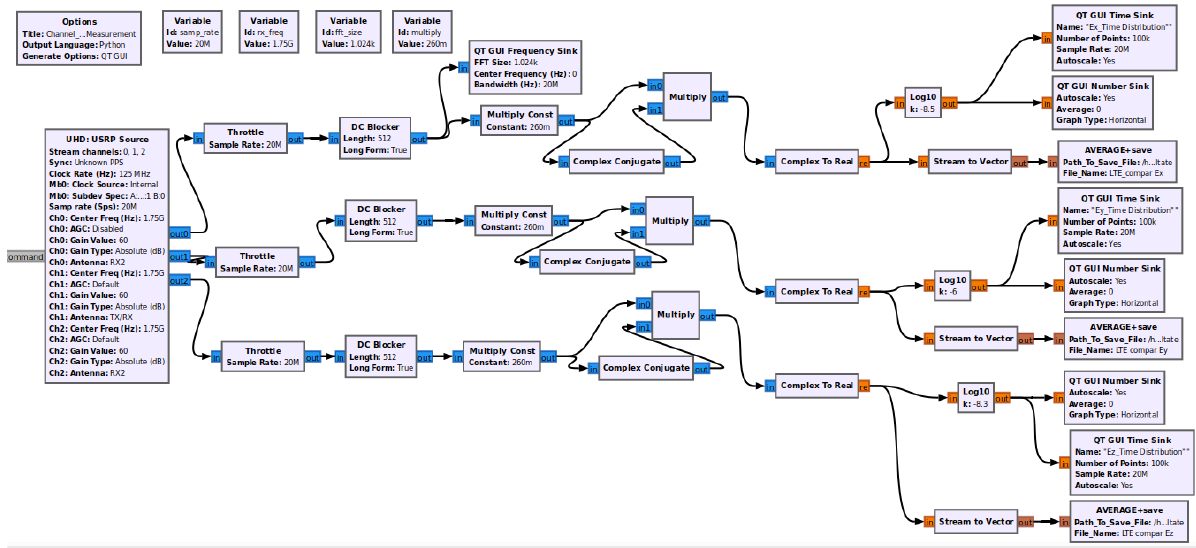
Figure 6. GNU Radio flowchart used for CP measurements using the SDR (USRP N310).